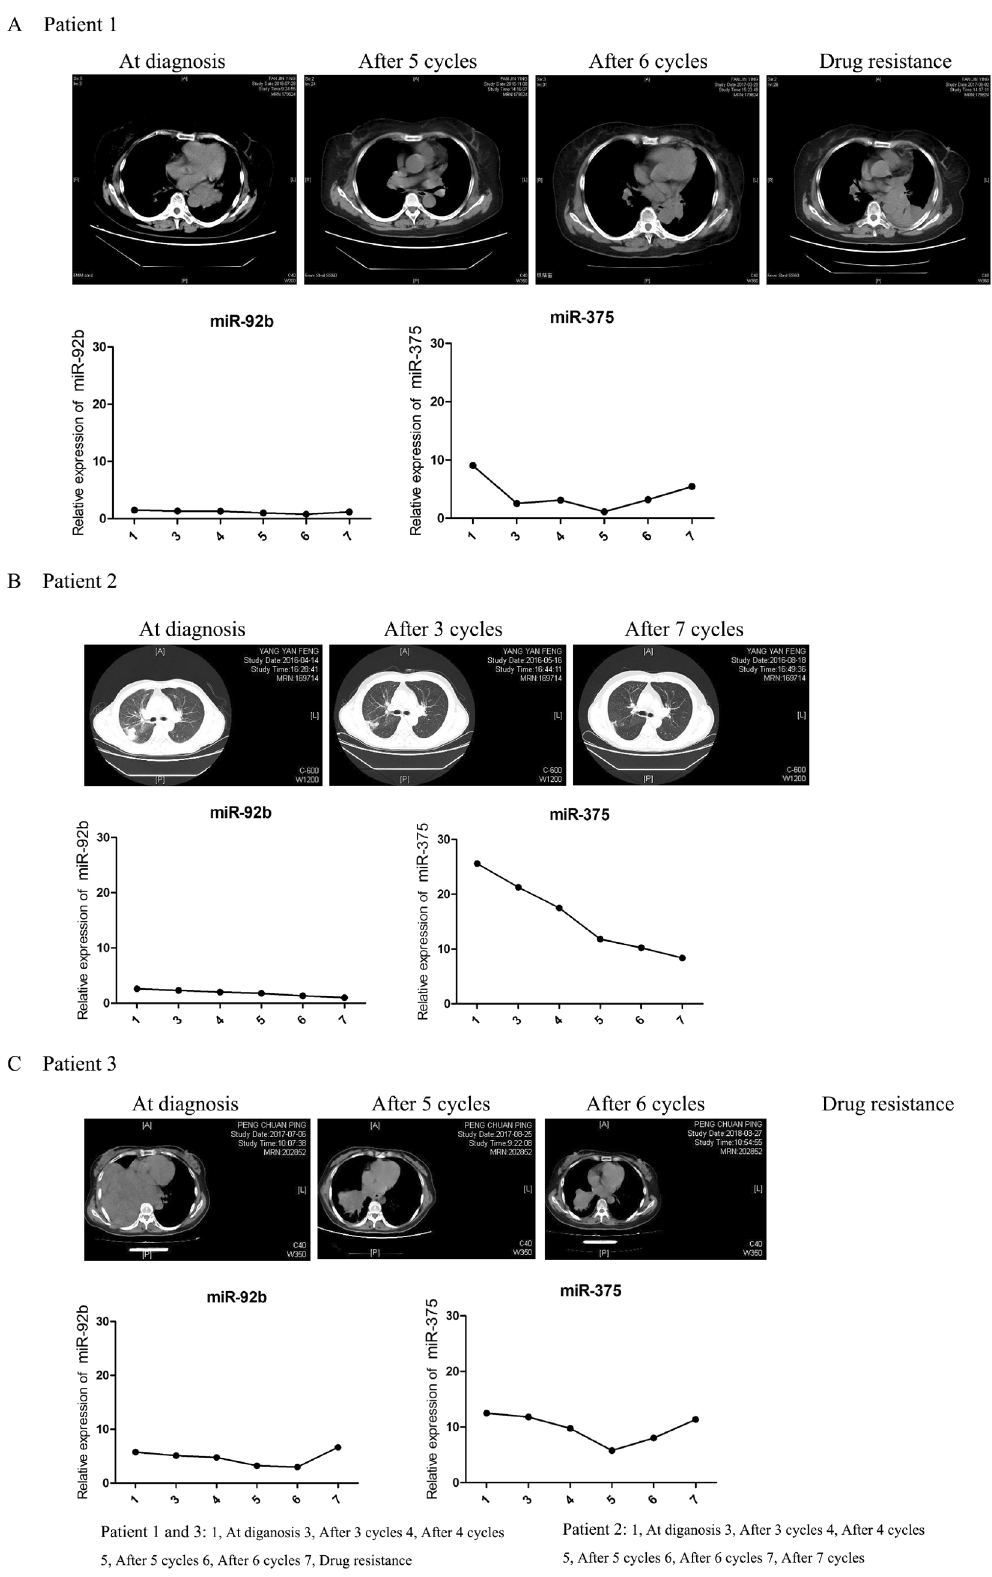
Figure 5. Changes in radiological characteristics and longitudinal analyses of miRNA levels during chemotherapy in three SCLC patients. ( A ) Patient 1. ( B ) Patient 2. ( C ) Patient